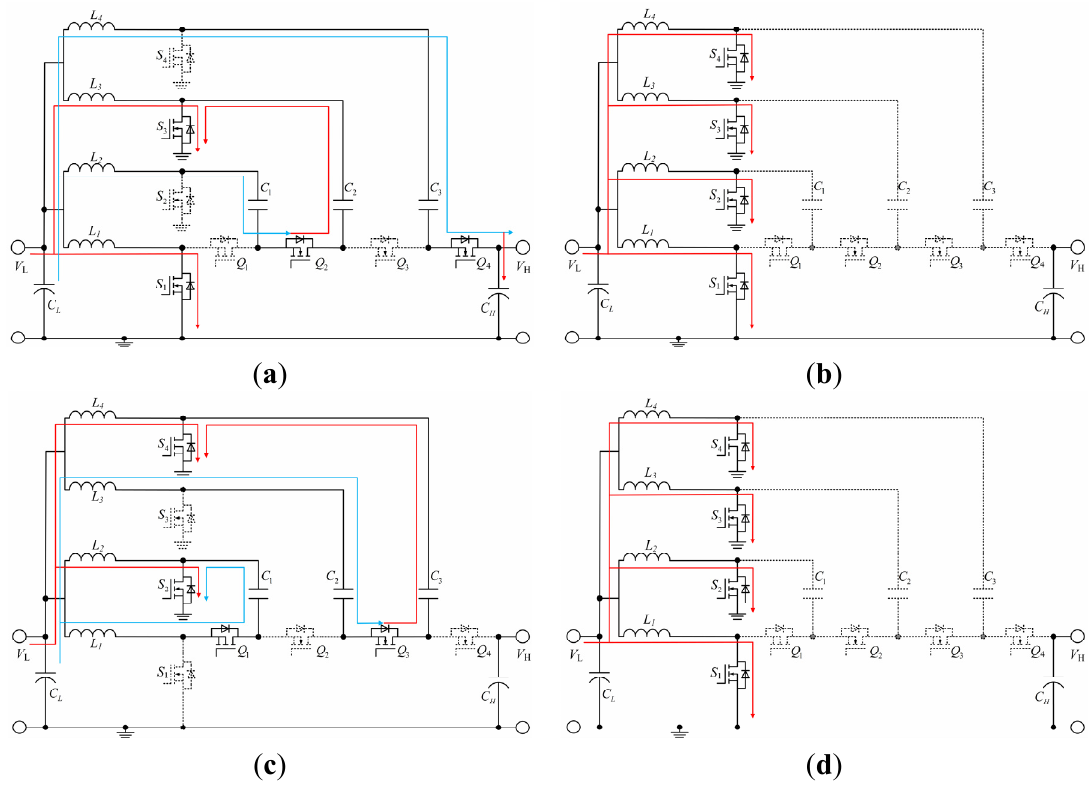
Figure 9. Equivalent circuits in CCM Boost stage ( a ) interval 1; ( b ) interval 2; ( c ) interval 3; ( d ) interval